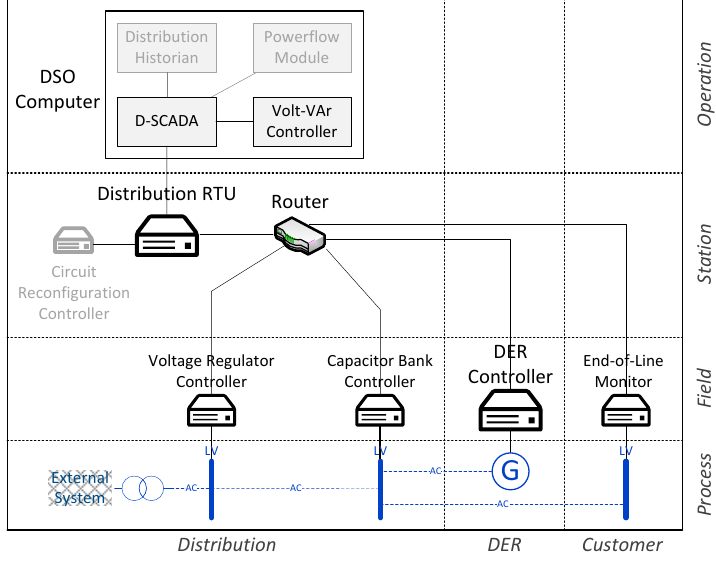
Figure 10. Overview of the example use case Integrated Volt VAr Control Centralized